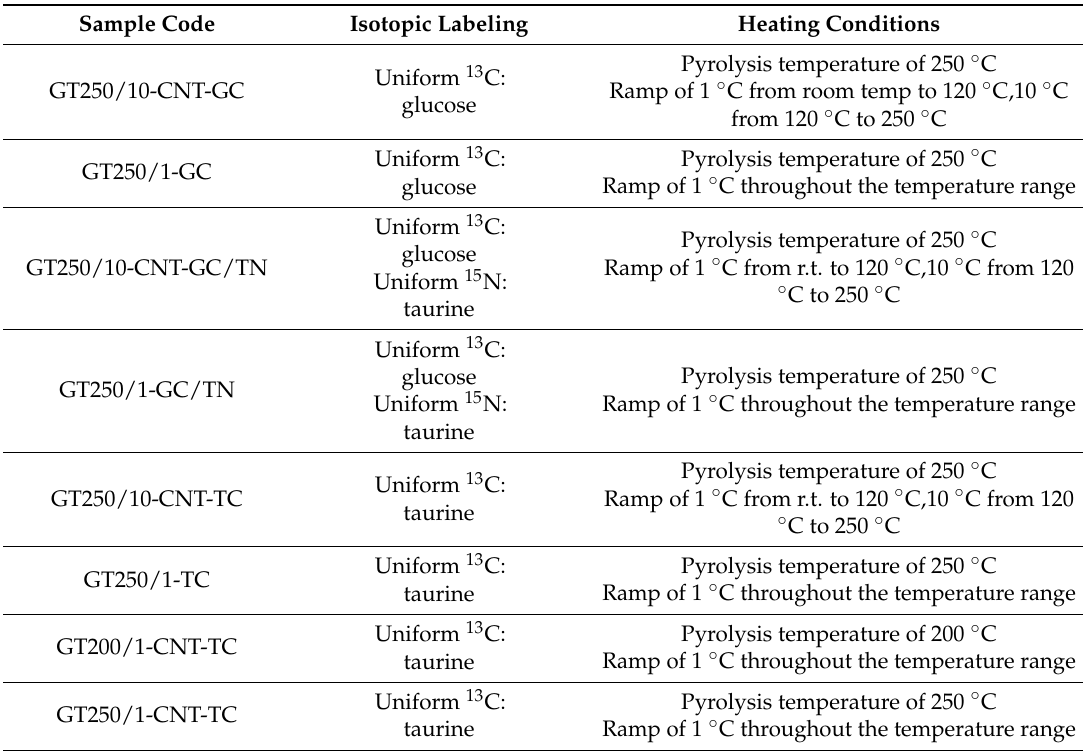
Table 1. Synthesis conditions of different materials a